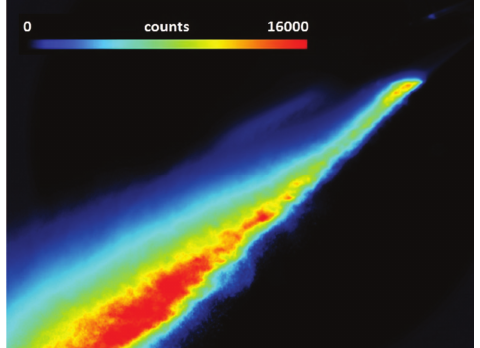
Fig. 7. Instantaneous LIF image after background subtraction